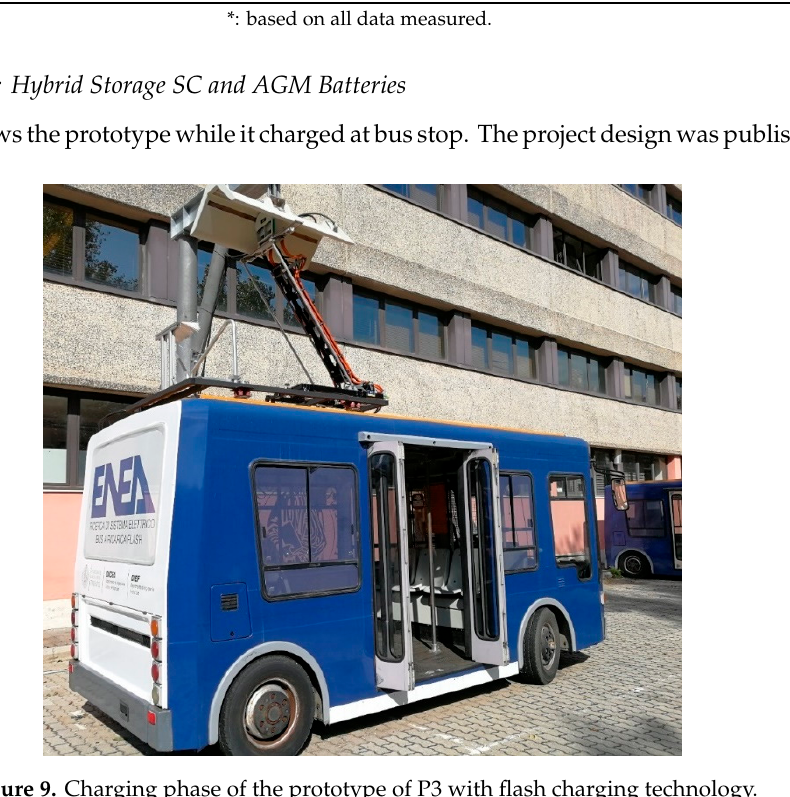
Figure 9. Charging phase of the prototype of P3 with flash charging technology.